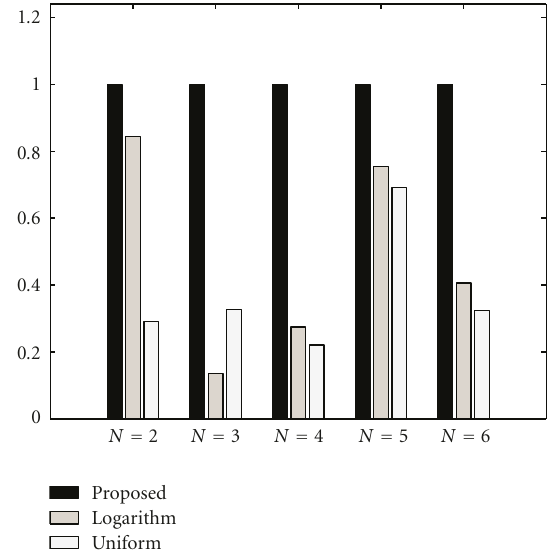
Figure 9: Summary of results with the polytope diversities normalized by the value corresponding to the proposed